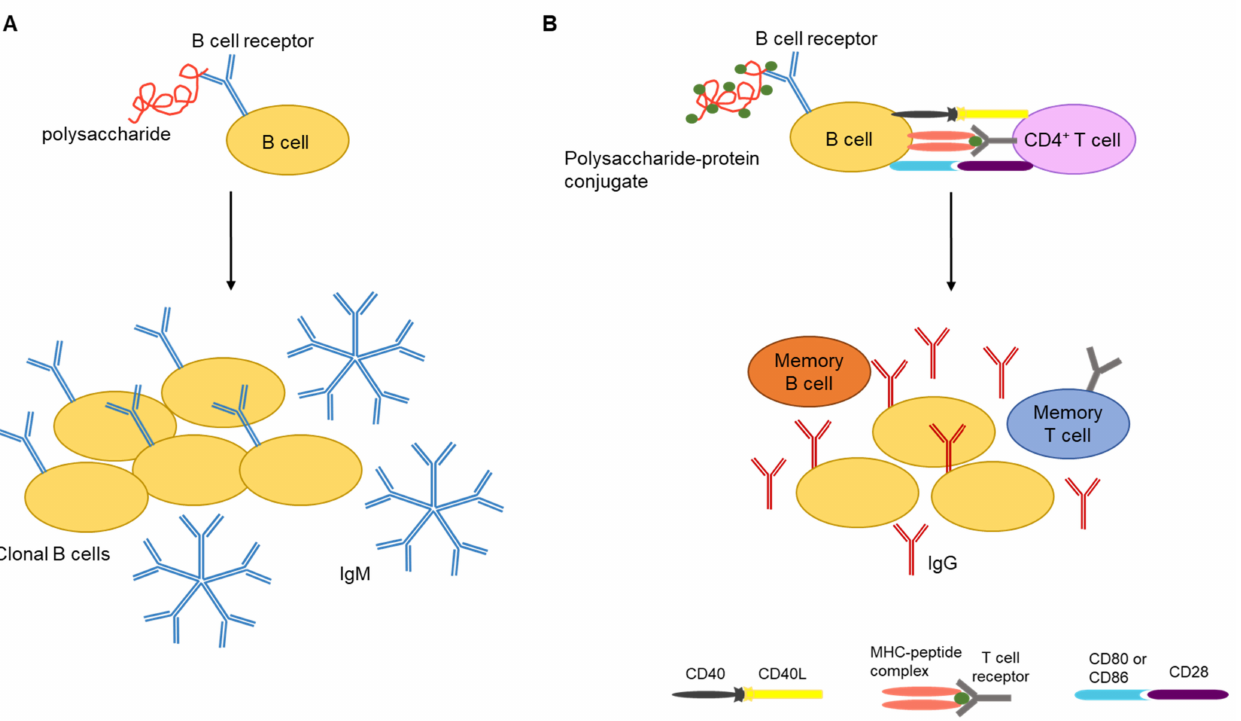
Figure 2. Antibody production in response to polysaccharide antigens. ( A ) Polysaccharide antigens alone lead to IgM production, while ( B ) polysaccharide–protein conjugated antigens lead to IgG production and immune